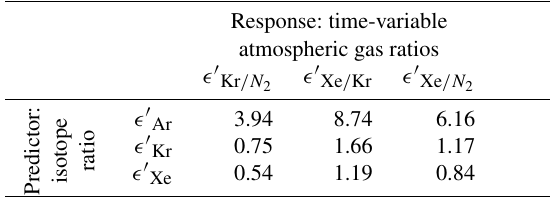
(cid:48) scaling factor in the 2-D model with barometric pumping Table 1. (cid:15) between different element and isotope ratios from linear regression of (cid:15) (cid:48) value pairs at all depths. R 2 > 0 . 996 for all relationships. Response: